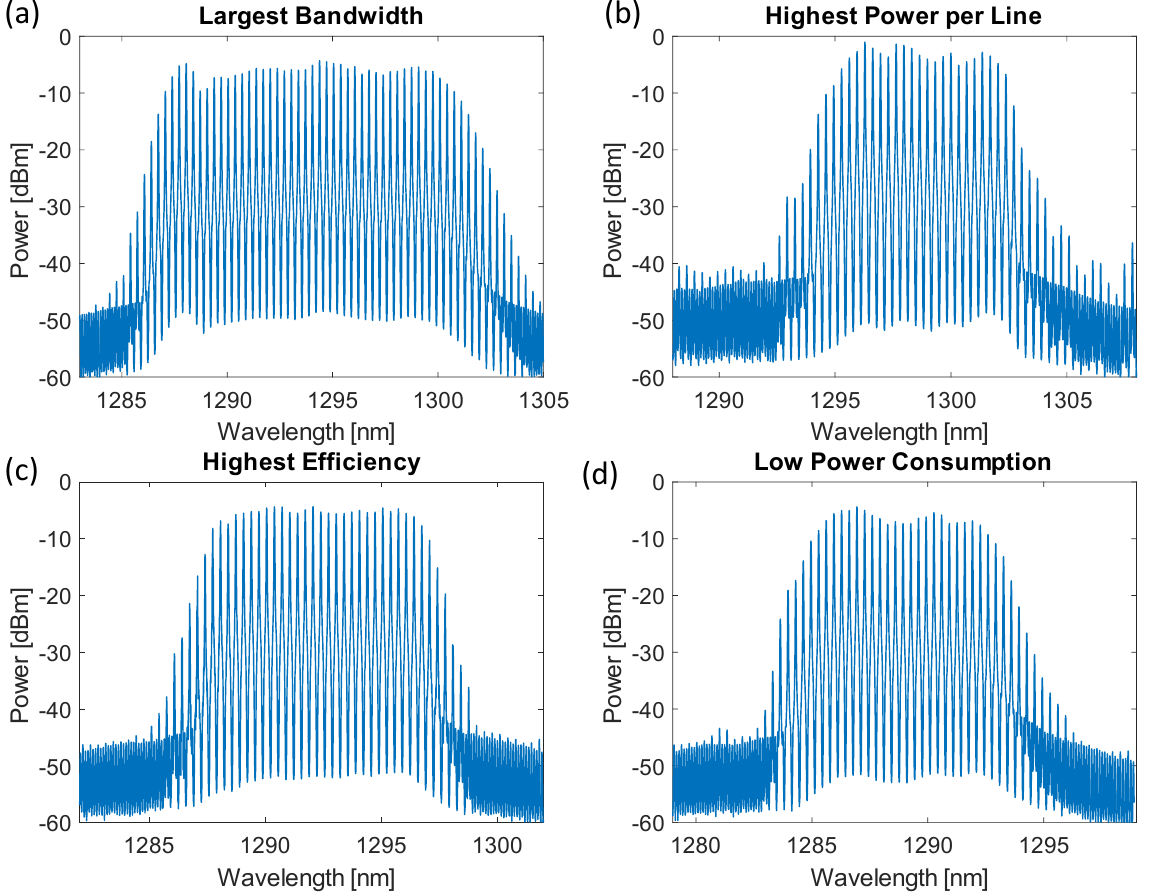
Figure 5. Optical spectra collected from the same device with a total saturable absorber length of 10% of the cavity. ( a ) Comb with the largest 6 dB bandwidth, 42 lines. ( b ) Comb with the highest power for 20 contiguous lines. ( c ) Comb with the highest efficiency of generating 20 contiguous lines. ( d ) Comb with low power consumption and high